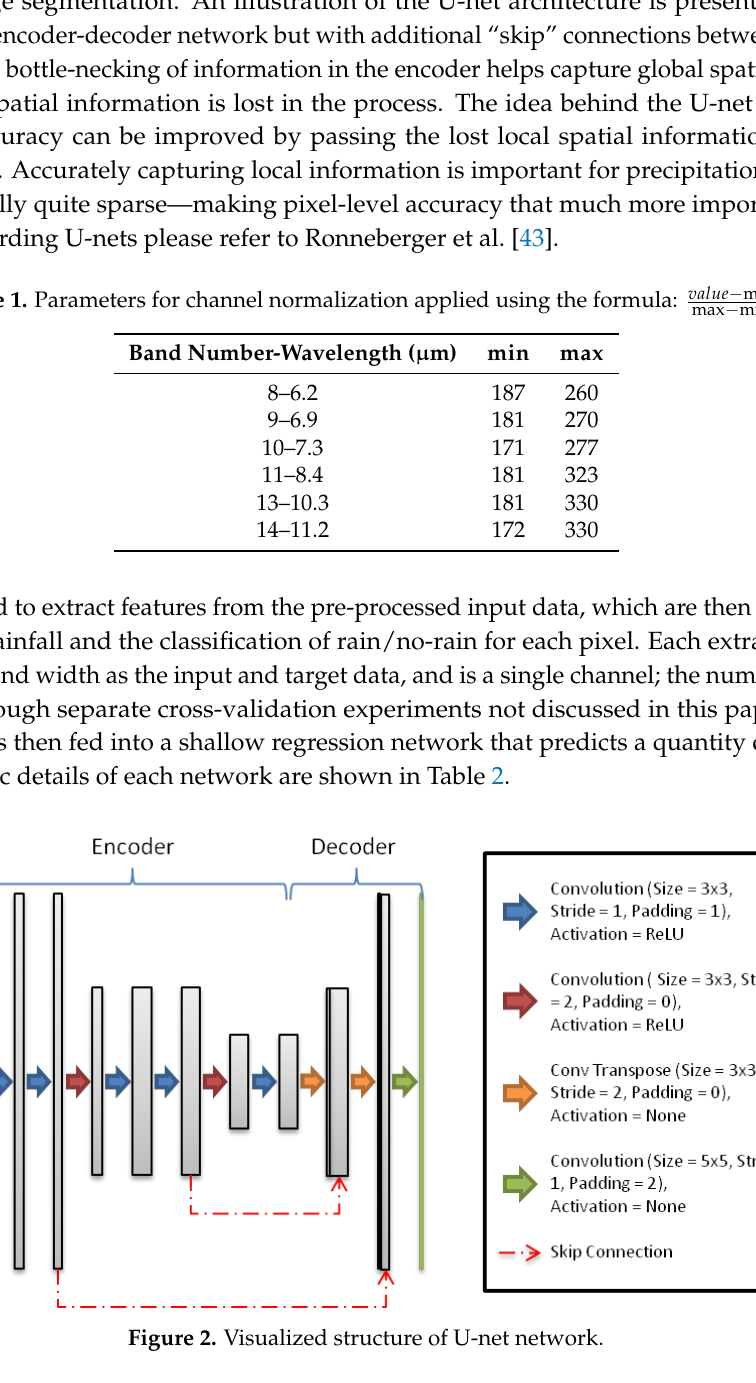
Table 1. Parameters for channel normalization applied using the formula: value − min